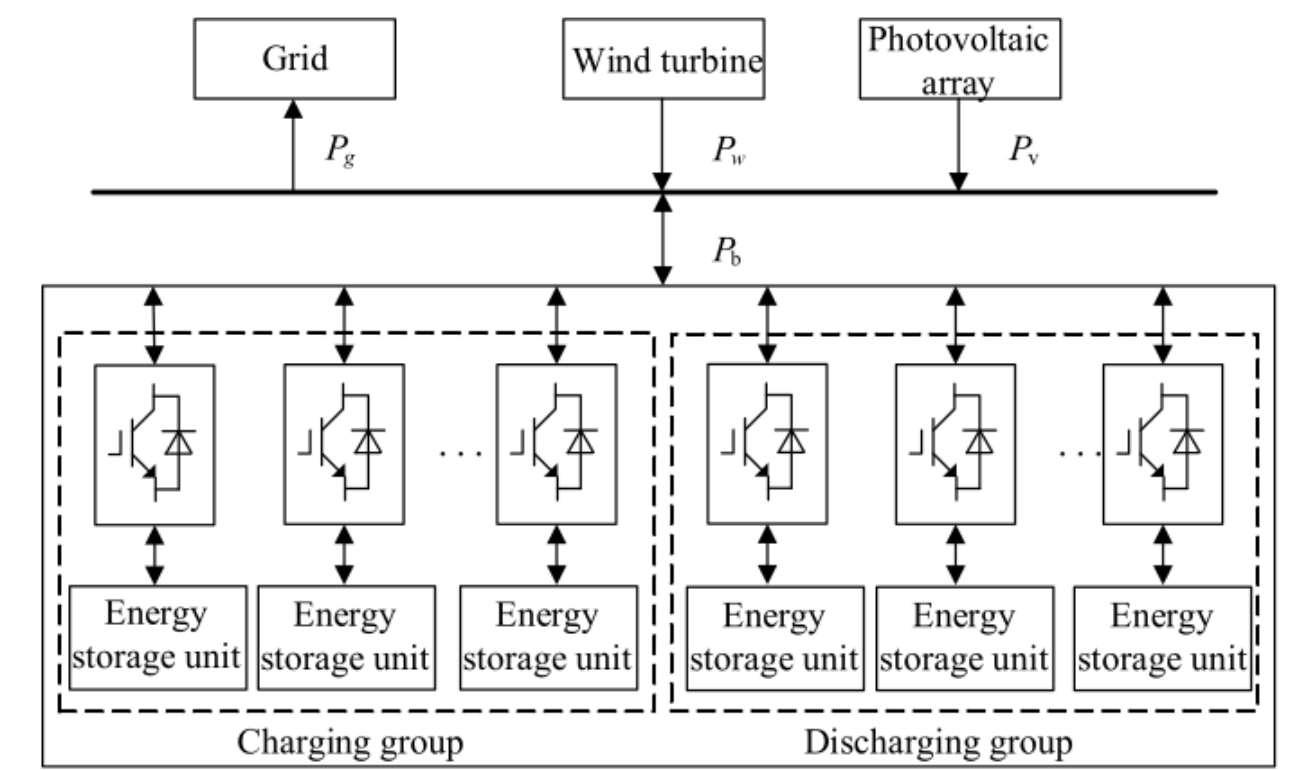
Figure 1. Wind–solar energy storage system